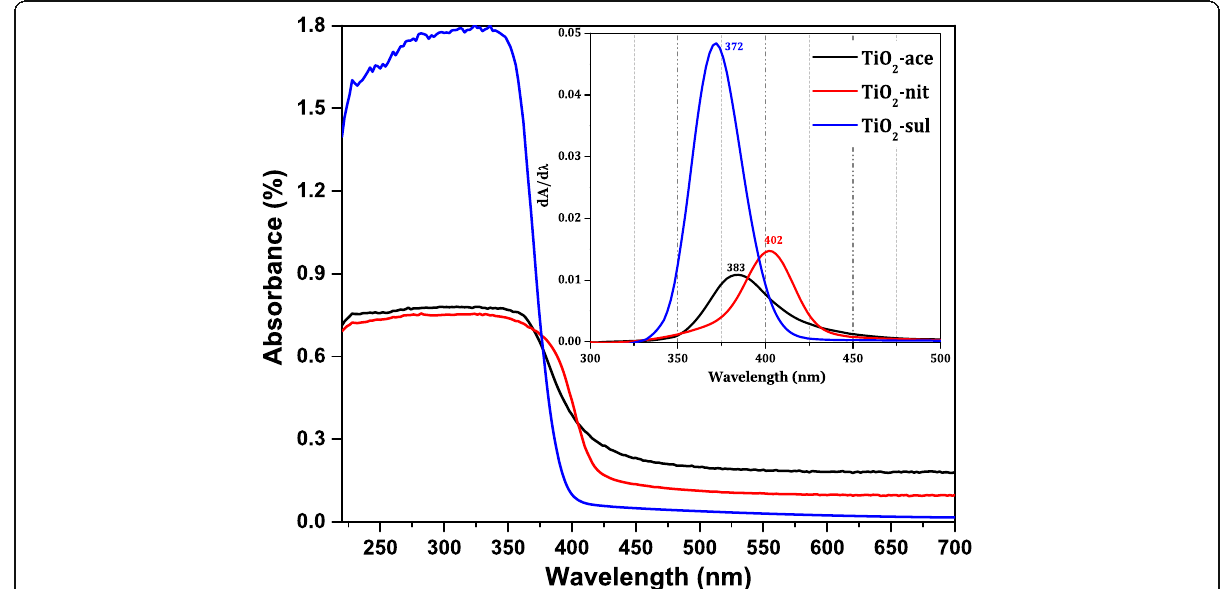
Fig. 4 DR UV- vis spectra of the calcined TiO 2 samples (inset; the derivative of the DR UV- vis spectra)